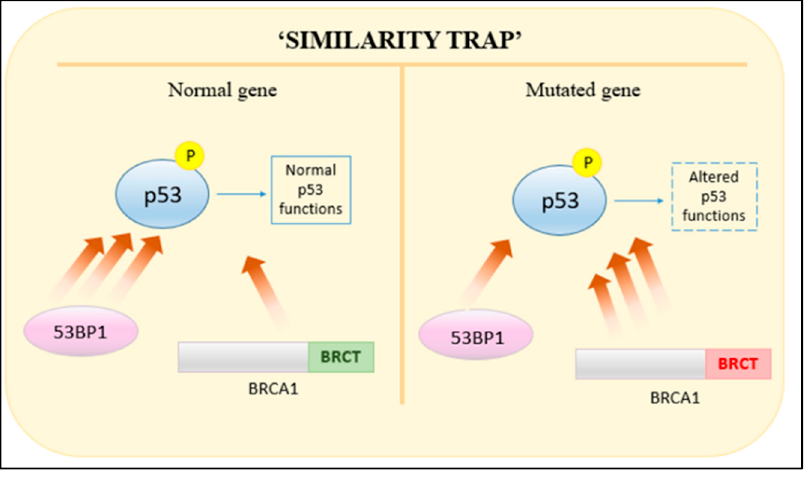
Figure 3. Reversal of affinities between mutated BRCA1 and 53BP1 towards phosphorylated p53.